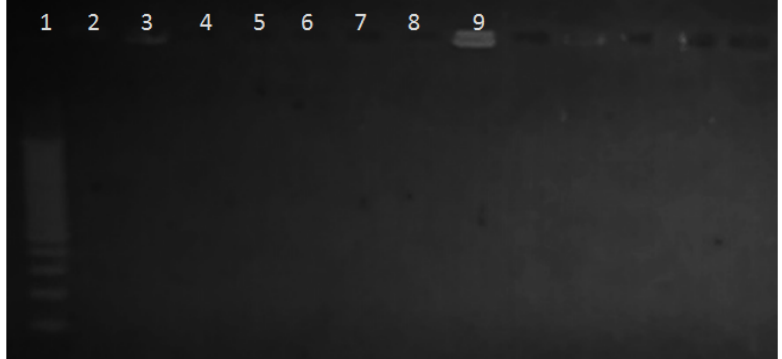
Fig. 2. Negative Multiplex PCRs targeting the O wzx and O wzy genes Lane 1 M, molecular weight , lane2-8 bacterial isolates lane 9, E coli HB101 . The Positive multiplex PCR showing the amplified wzx 255 bp and wzy 451